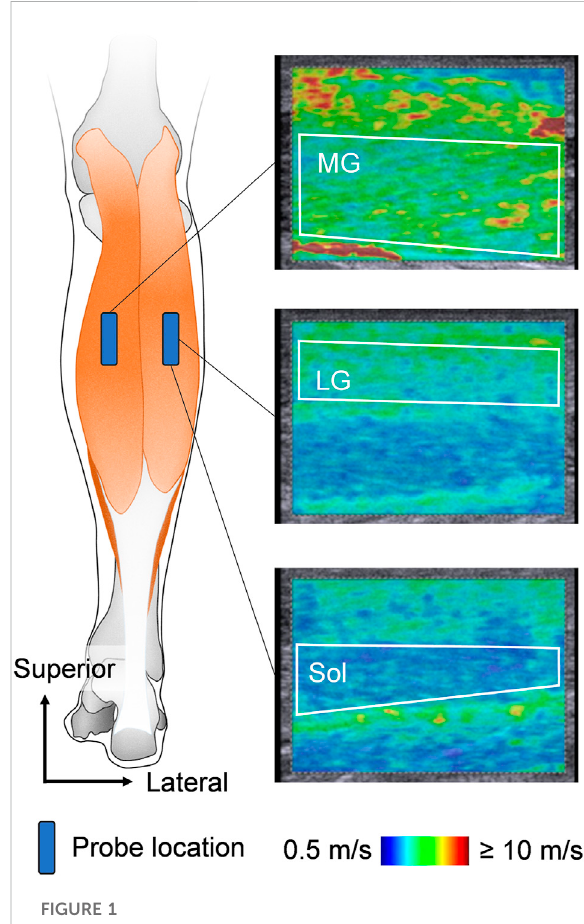
FIGURE 1 Schematic representation of ultrasound probe locations and typical examples of ultrasound shear wave elastographic images. The area surrounded by the white line is the region of interest for shear wave speed analysis. MG: medial gastrocnemius, LG: lateral gastrocnemius, and Sol: